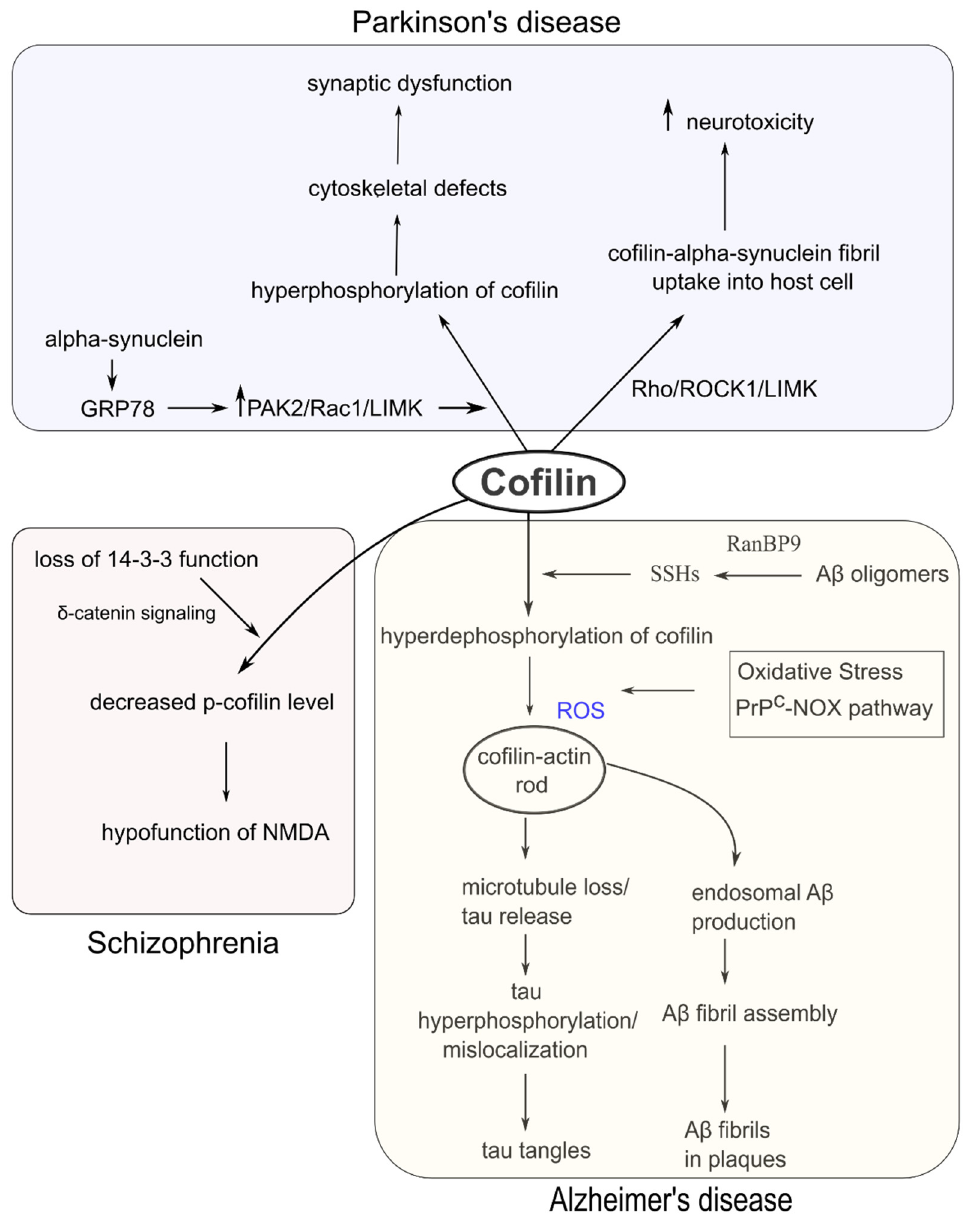
Figure 4. Dysregulation of cofilin in neurodegenerative and psychiatric disorders. Upper (cofilin dysfunction in PD): Alpha- synuclein can induce cofilin hyperphosphorylation leading to synaptic aberration. Alpha-synuclein can also interact with cofilin to form cofilin-alpha-synuclein fibrils and enhance neurotoxicity. Lower left (cofilin dysfunction in schizophrenia): Functional loss of 14-3-3 decreases the p-cofilin level and NMDA function. Lower right (cofilin dysfunction in AD): A β oligomers can activate SSHs and induce cofilin hyperdephosphorylation, which enhances cofilin-actin rod formation in the presence of excess ROS. Cofilin-actin rods can further accelerate the formation of tau tangles and A β plaques.